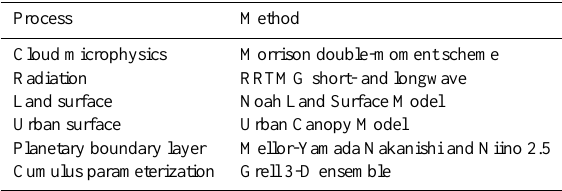
Table 1. Chosen parameterization for selected physical processes in WRF.